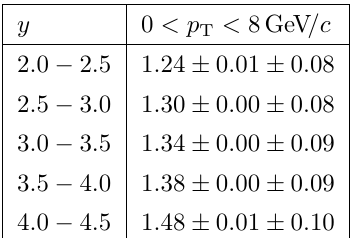
Table 11 . Cross-section ratios between 8 TeV and 5 TeV measurements for prompt J/ψ mesons as a function of y with p T < 8 GeV/ c . The first uncertainty is statistical and the second is